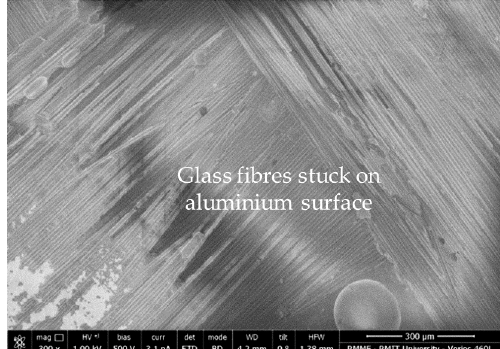
Figure 8. SEM image showing the glass fibres that remained bonded to the aluminium adherend following delamination